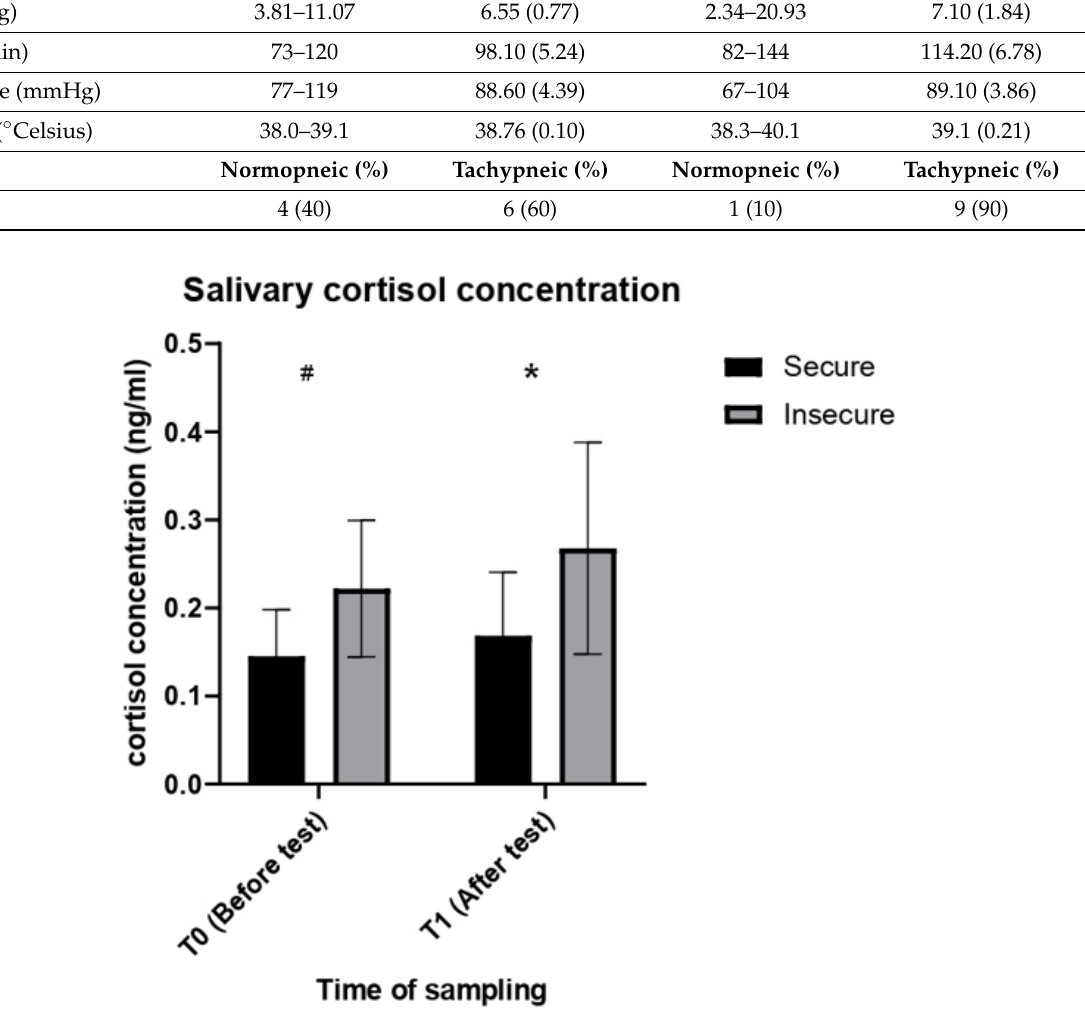
Figure 1. Salivary cortisol concentrations in secure and insecure dogs before (T0) and after the